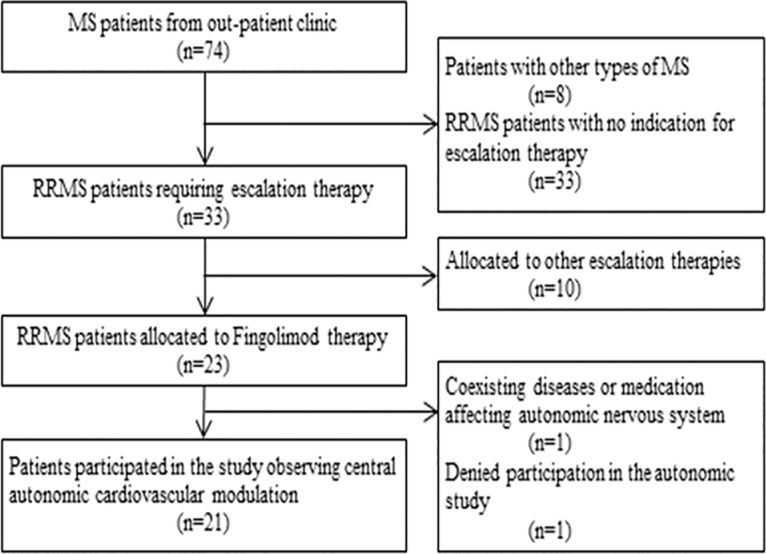
Flowchart of study patients.